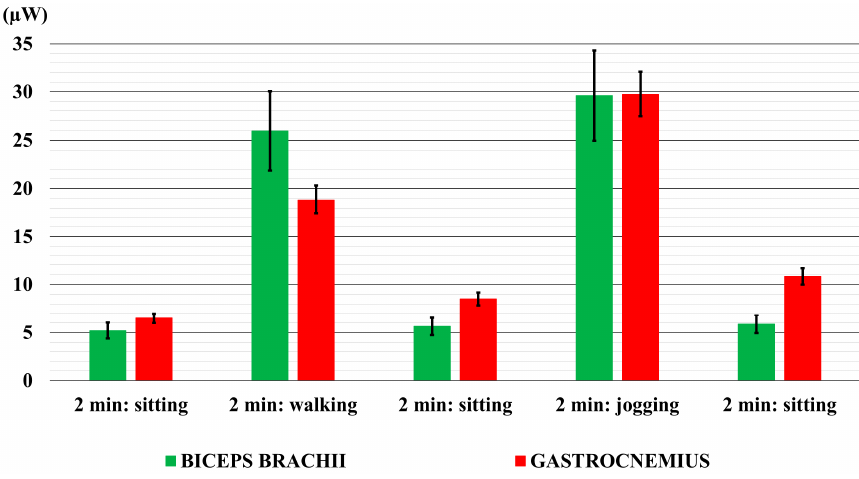
Figure 8. The mean values of the power output generated by the TEG on the calf, in correspondence to the gastrocnemius muscle (red bars), and on the arm anterior in correspondence to the biceps brachii muscle (green bars). Error bars represent standard deviation values.